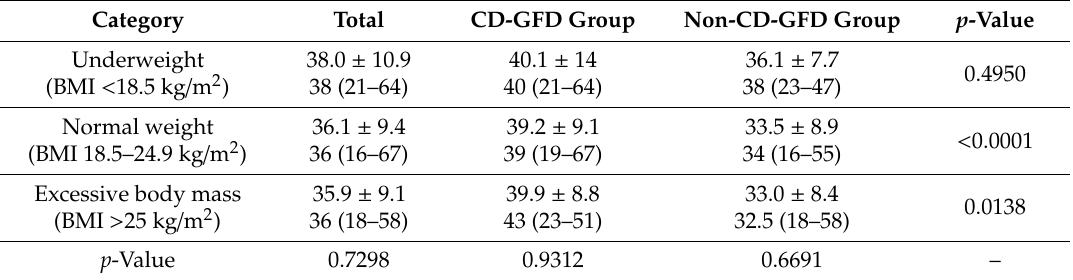
Table 5. Food Neophobia Scale (FNS) scores stratified by BMI in the sub-groups of CD-GFD and non-CD-GFD individuals (mean ± SD and median accompanied by